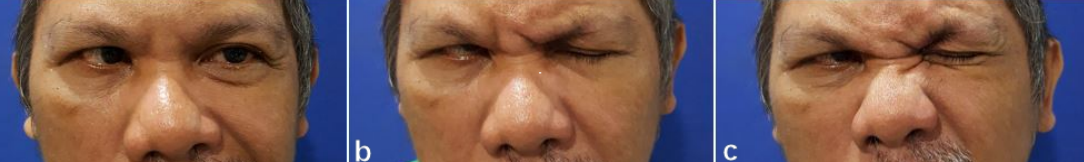
Figure 1: Composite diagram